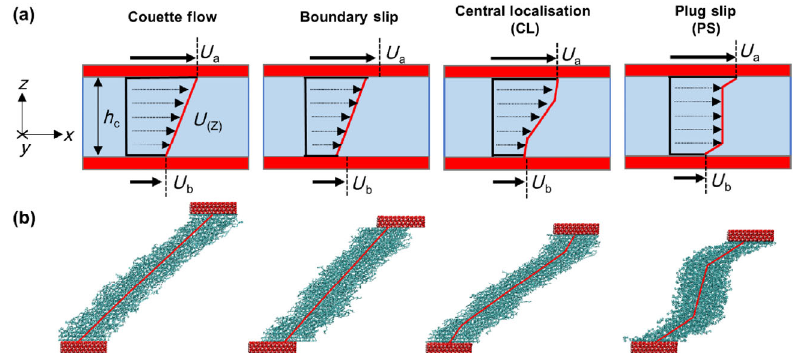
Fig. 4 Schematic showing different types of flow behaviour in confined fluid films under extreme conditions for two surfaces separated by distance h c , moving at velocities of U a and U b (a). Images showing examples of the flow behaviour from NEMD simulations are adapted from Ref. [29]